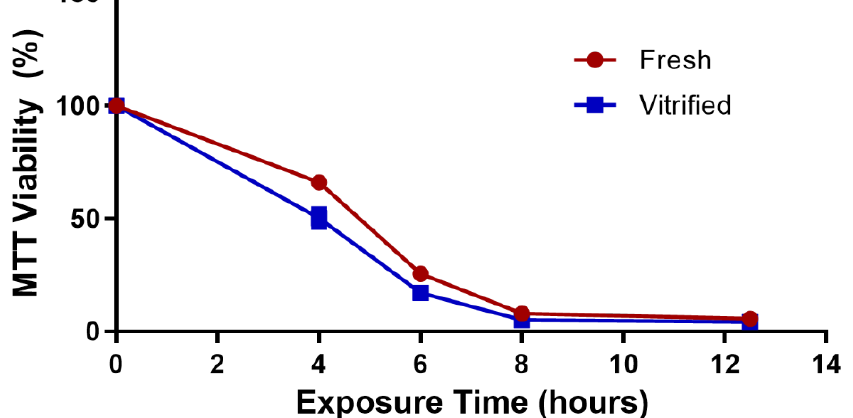
Figure 6. Viability of fresh and vitrified EpiDerm constructs after exposure to Triton-X100. Fresh constructs were assessed immediately, vitrified constructs were preserved using DP6 for the load/unload steps (5 min) and VS70 for vitrification. Viability was measured using the MTT assay and is the mean (± SEM) of ≥12 replicates. No significant differences were observed by one-way ANOVA with Tukey’s multiple comparison test.